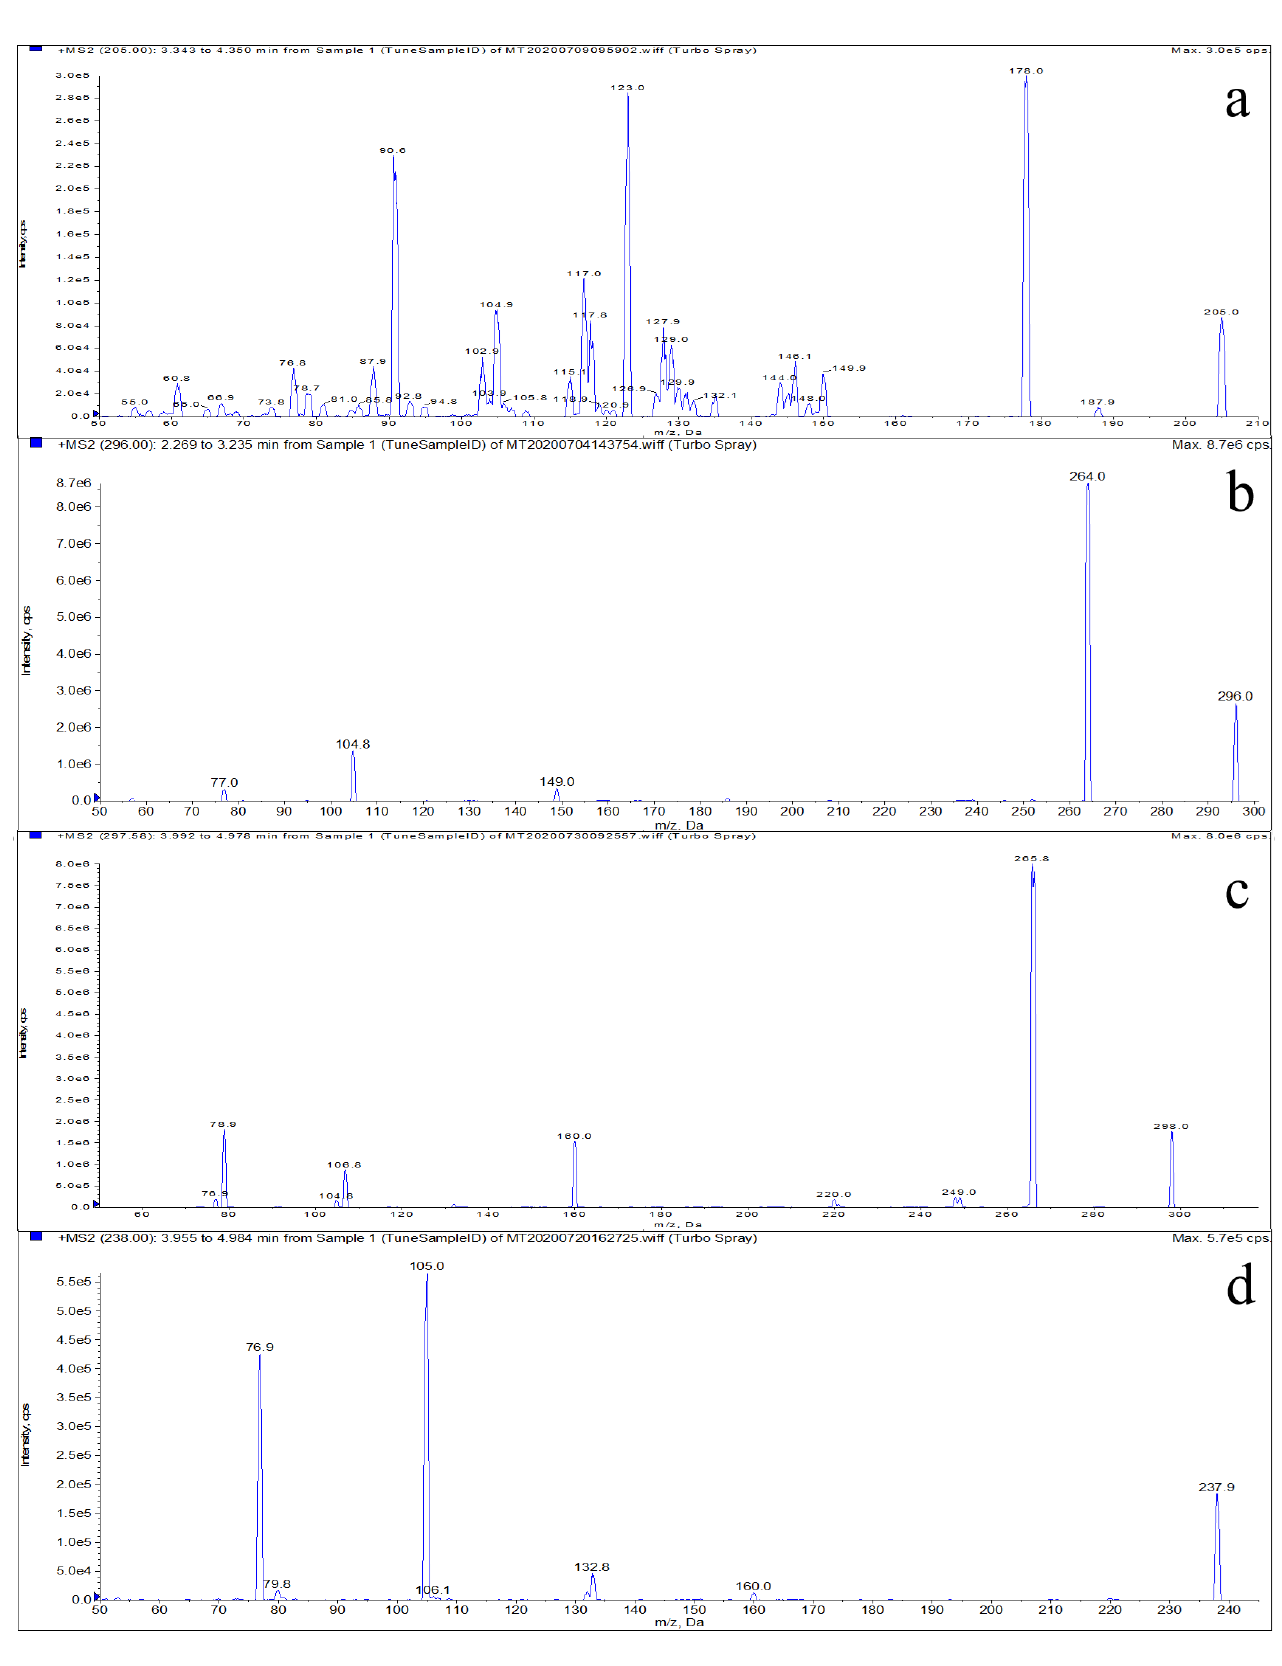
Figure 1. Mass spectra of LMS ( a ), MBZ ( b ), HMBZ ( c ) and AMBZ ( d ).